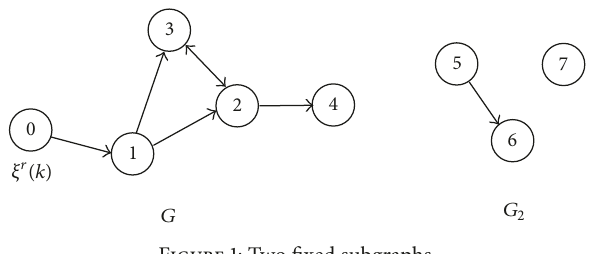
Figure 1: Two fixed subgraphs.